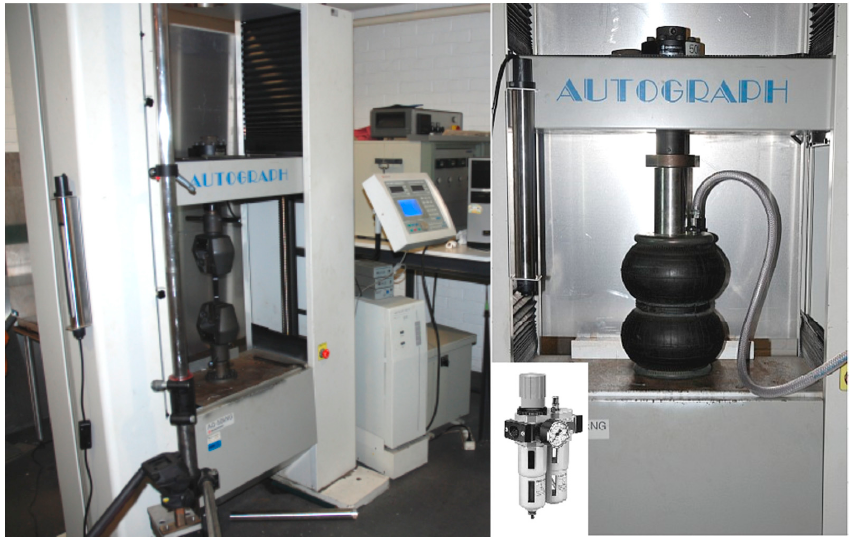
Figure 10. Mounting of the bellows pneumatic accessory in a SHIMADZU ® testing machine between the working table and upper crosshead with an adaptor ram and a pressure air control